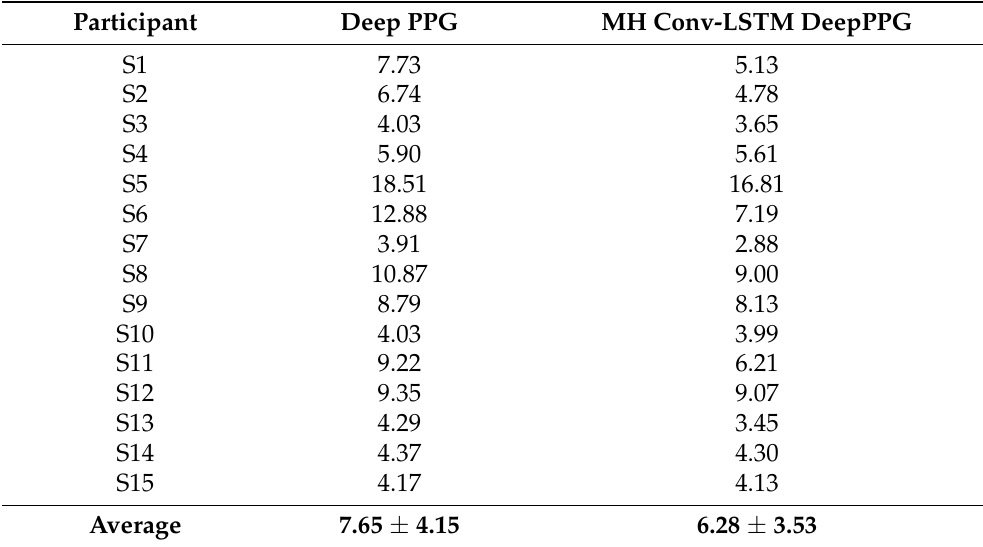
Table 8. Comparison of model performance, MAE (bpm). Performance of Deep PPG taken from [13], Table 10.